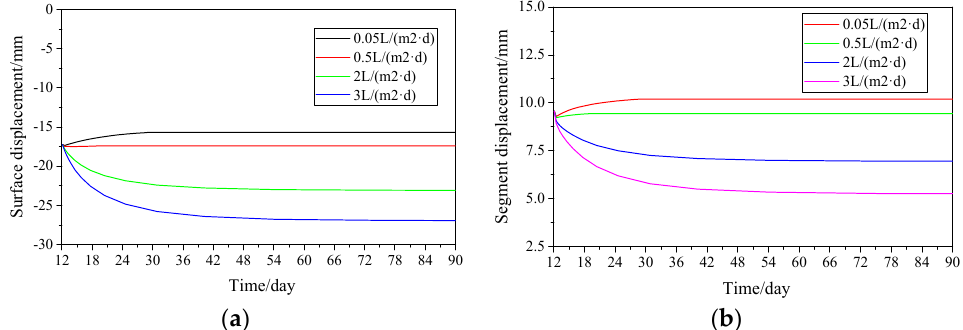
Figure 12. Displacement of surface and tunnel under different tunnel seepage volume. ( a ) Development of surface displacement with time; ( b ) Development of segment displacement with time.